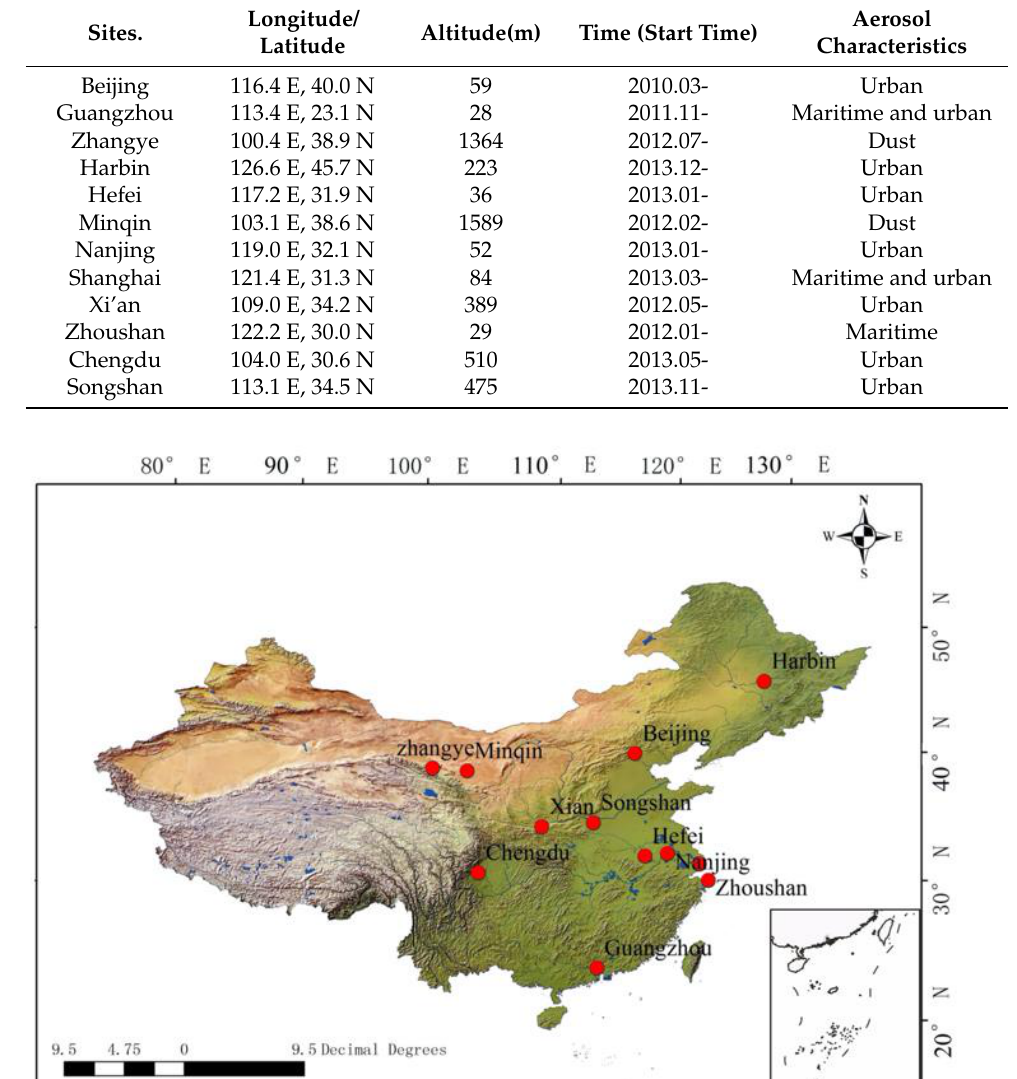
Table 1. Basic information on the 12 SONET sites.